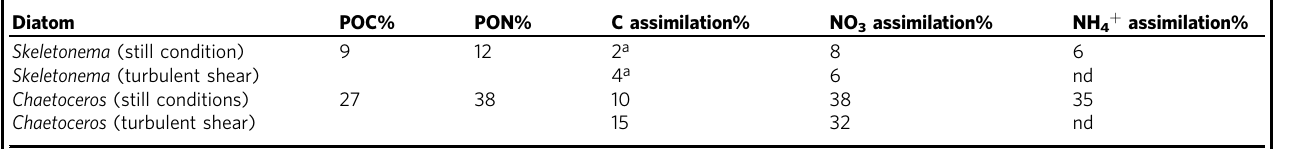
POC: Particulate organic carbon, PON: particulate organic nitrogen POC, PON, C-, nitrate assimilation and ammonium assimilation in % of the total phytoplankton community under still conditions and turbulent shear a Differences in cell-speci fi c rates were statistically signi fi cant between still conditions and turbulent shear (two-way ANOVA, DF: 598; p <0.0001)